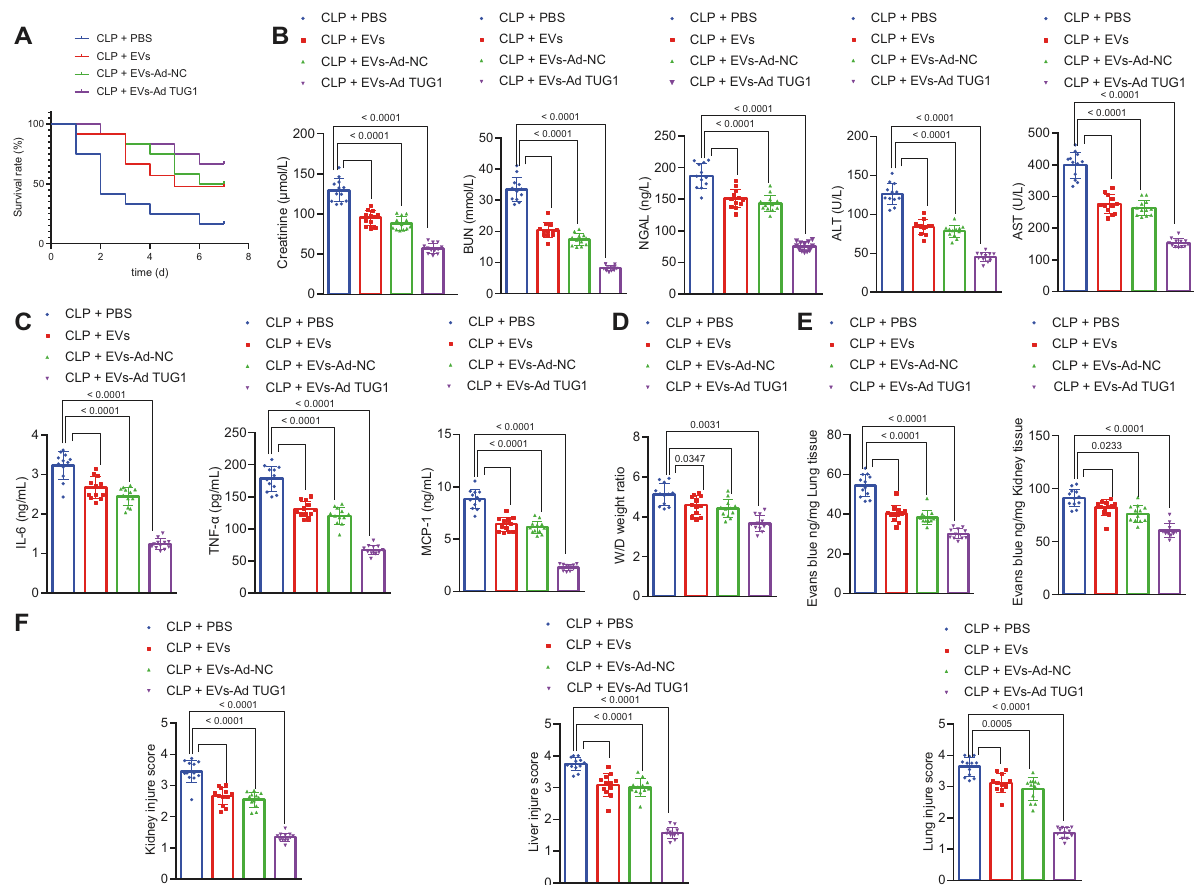
Fig. 7 EPC-derived EVs carrying TUG1 alleviate multiple organ damage induced by sepsis. A The survival rate of mice within 7 days after CLP analyzed by Kaplan – Meier analysis. B Measurement of creatinine, BUN, NGAL, AST, and ALT levels in mouse serum. C Serum levels of IL-6, TNF- α , and MCP-1 assessed by ELISA 24h after surgery. D Pulmonary edema in mice assessed by the wet/dry ratio. E The measurement of blood vessel leakage in lung and liver of mice by injecting Evans blue dye. F The morphological changes of lung, liver, and kidney tissues observed by HE staining 24 h after CLP. Measurement data were expressed as mean ±standard deviation. One-way ANOVA was adopted for comparison between multiple groups followed by Tukey ’ s post hoc test. Kaplan – Meier analyses were performed to calculate the survival rate. Log-rank test was conducted for univariate survival analysis. * p < 0.05 vs. sham-operated mice; # p <0.05 vs. CLP-operated mice treated with Ad-NC ( n =